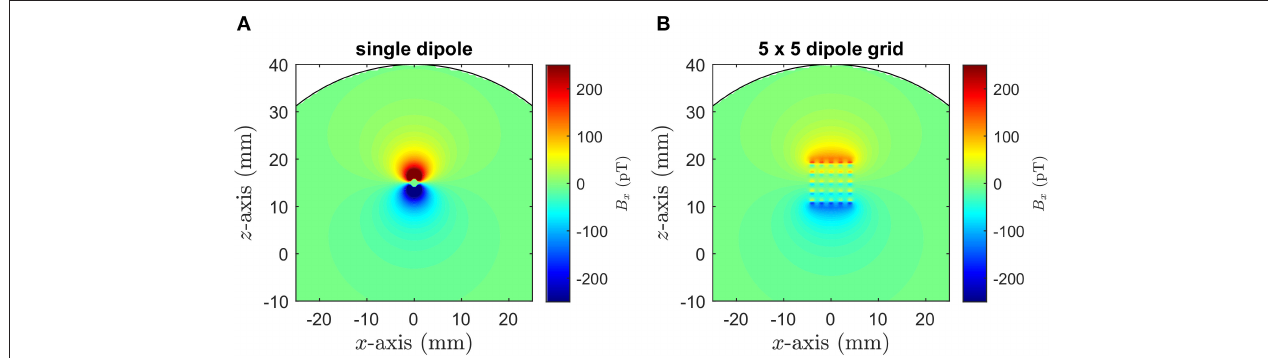
FIGURE 5 | FEM simulation of the internal B x field maps obtained for an applied current of 5 µ A for (A) the single dipole and (B) the 5 × 5 dipole grid. The electrodes are parallel to the y -direction with the single dipole and the center of the dipole grid 15 mm above the spherical phantom center.